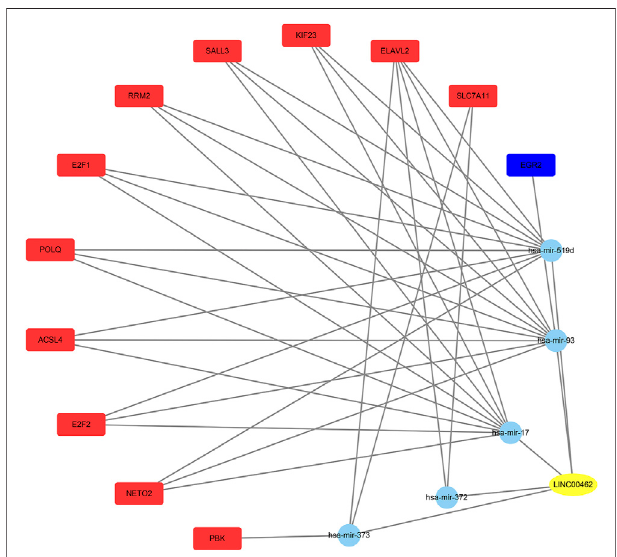
FIGURE 6 | The yellow oval is lncRNA, the blue circles represent miRNAs, the red rectangles represent the up-regulated mRNAs, and the blue rectangle represents the down-regulated